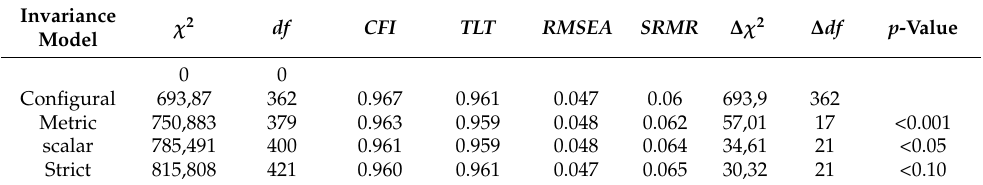
Table 4. Measurement Invariance for Gender.